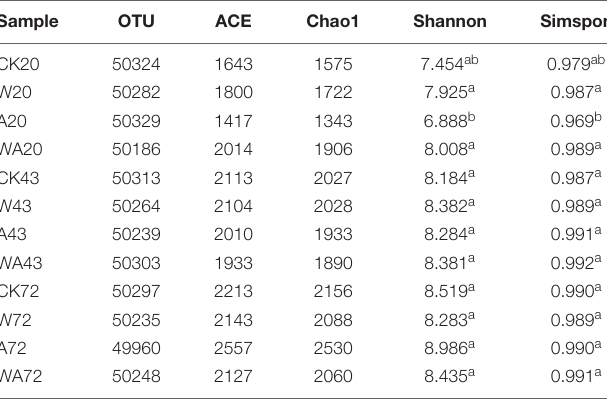
TABLE 2 | Summary of the alpha diversity of bacterial communities in samples from different periods.